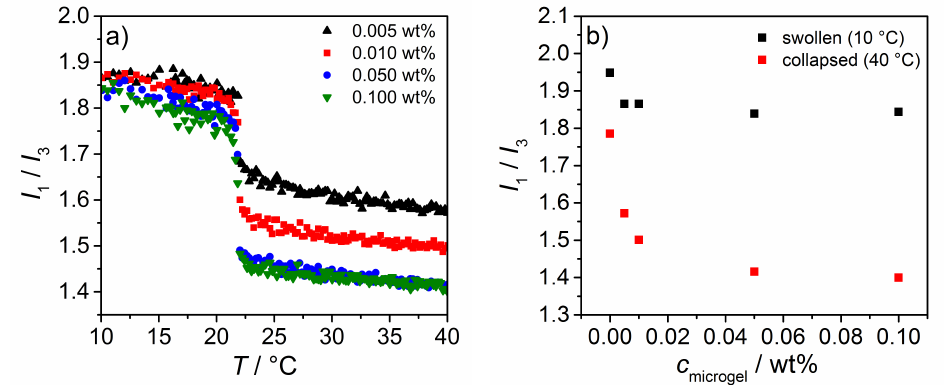
Figure 13. Plot of the intensity ratio I 1 / I 3 as a function of temperature for PNNPAM microgel solutions with different concentrations ( left ). Additionally, the concentration dependent change in I 1 / I 3 for the swollen and collapsed microgel is shown ( right